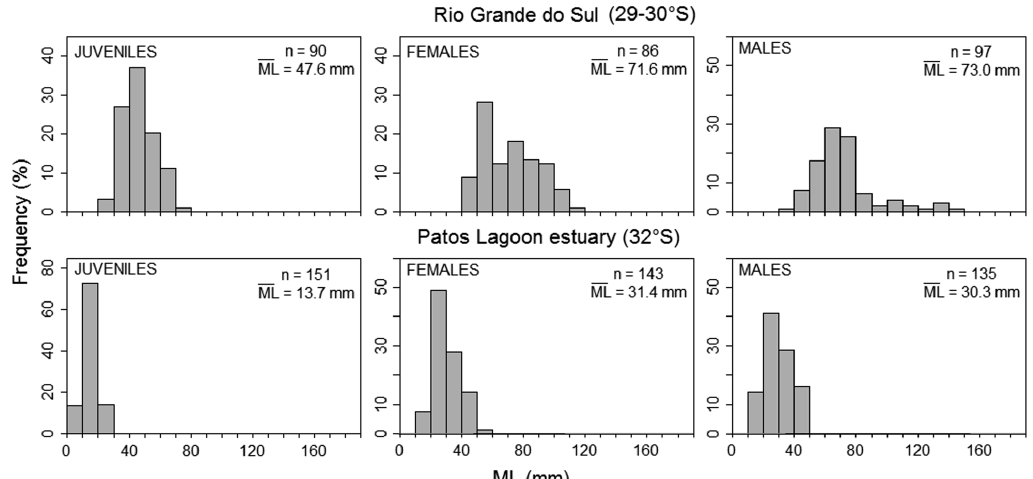
Figure 7. Size structure of Doryteuthis sanpaulensis according to the subareas nested within the Rio Grande do Sul coast (29–33.7°S). Note de different y-axis.